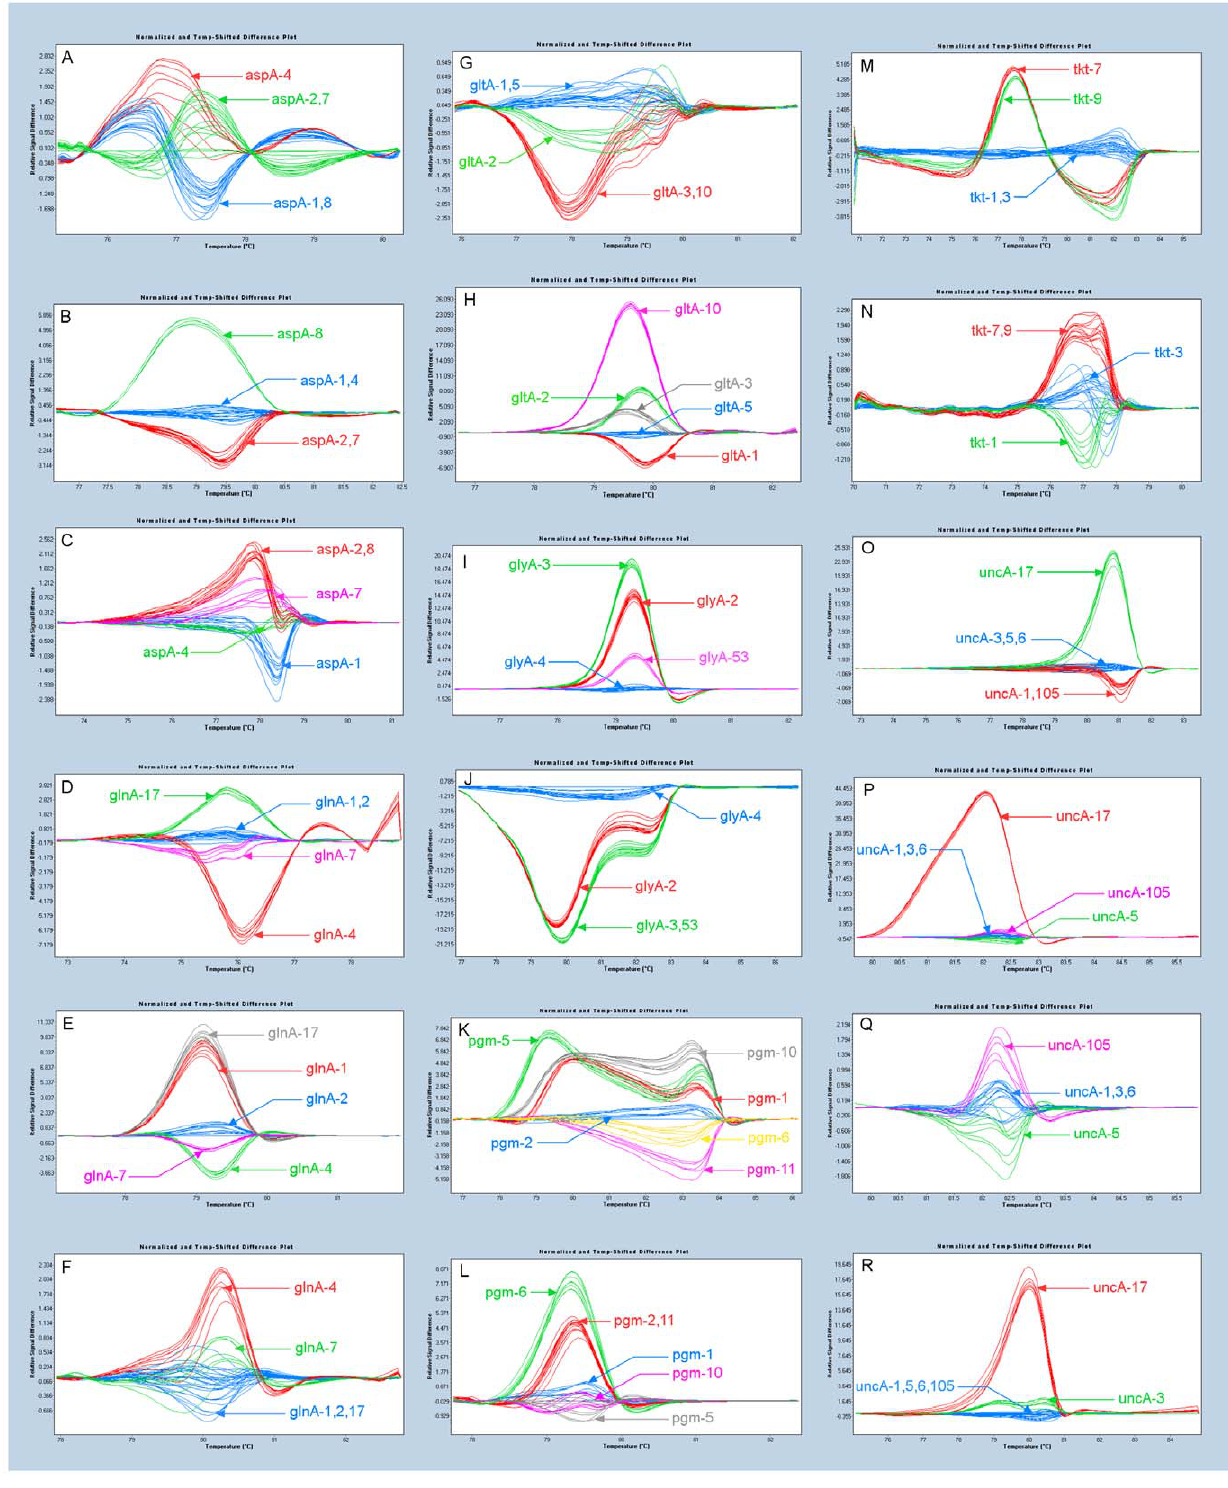
Figure 1. Difference plots for the normalized and temperature shifted melting curves for all locus fragments. A: asp left. B: asp middle. C: asp right. D: gln left. E: gln middle. F: gln right. G: glt left. H: glt right. I: gly left. J: gly right. K: pgm left. L: pgm right. M: tkt left. N: tkt right. O: unc left. P: unc middle. Q: unc middle without allele unc-17. R: unc right. Arrows link allele numbers with corresponding same color curves.